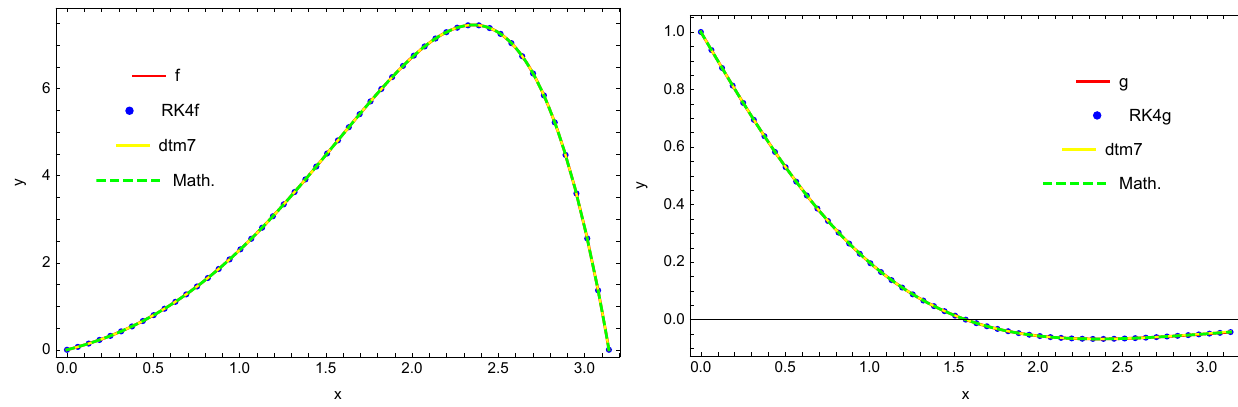
Figure 2. Exact solution and the approximate